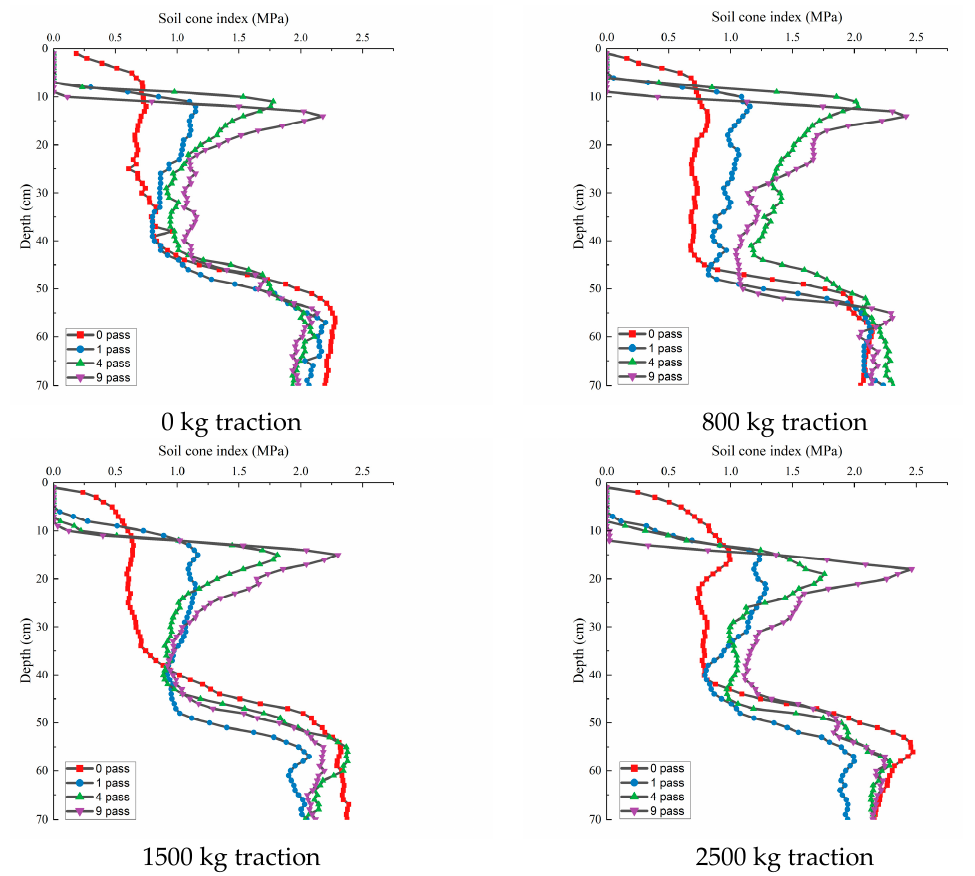
Figure 14. Soil cone index in different traction conditions with different numbers of passes.